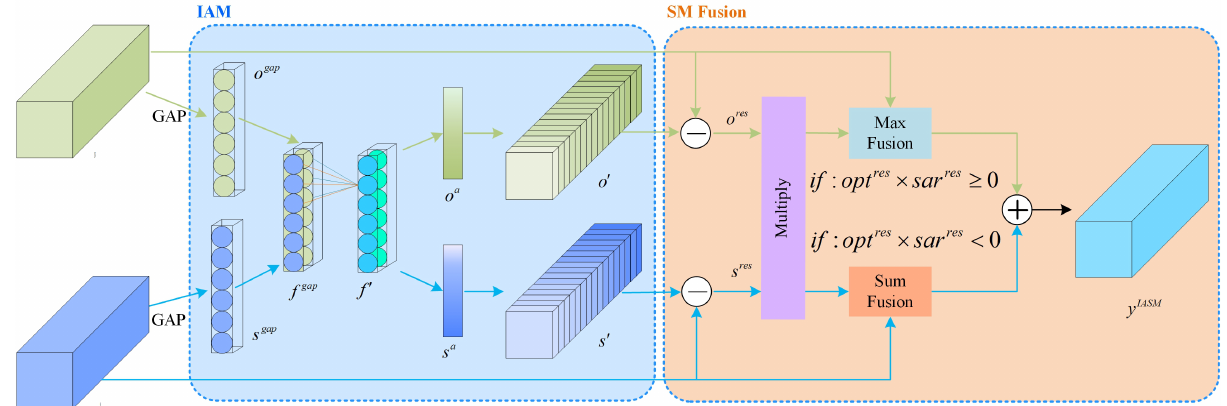
Figure 6. Structure of IASM in detail. The blue part is the interactive attention module. The orange part is the SM Fusion